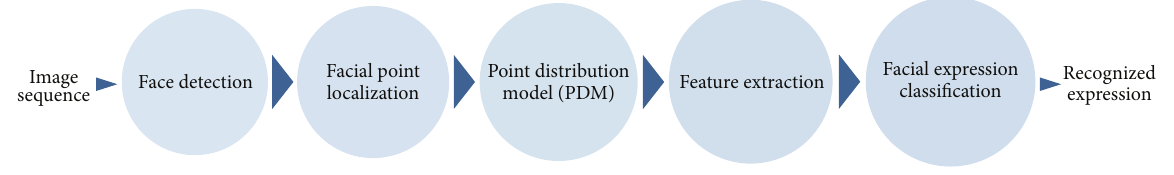
Figure 1: The structure of the proposed facial expression recognition approach.